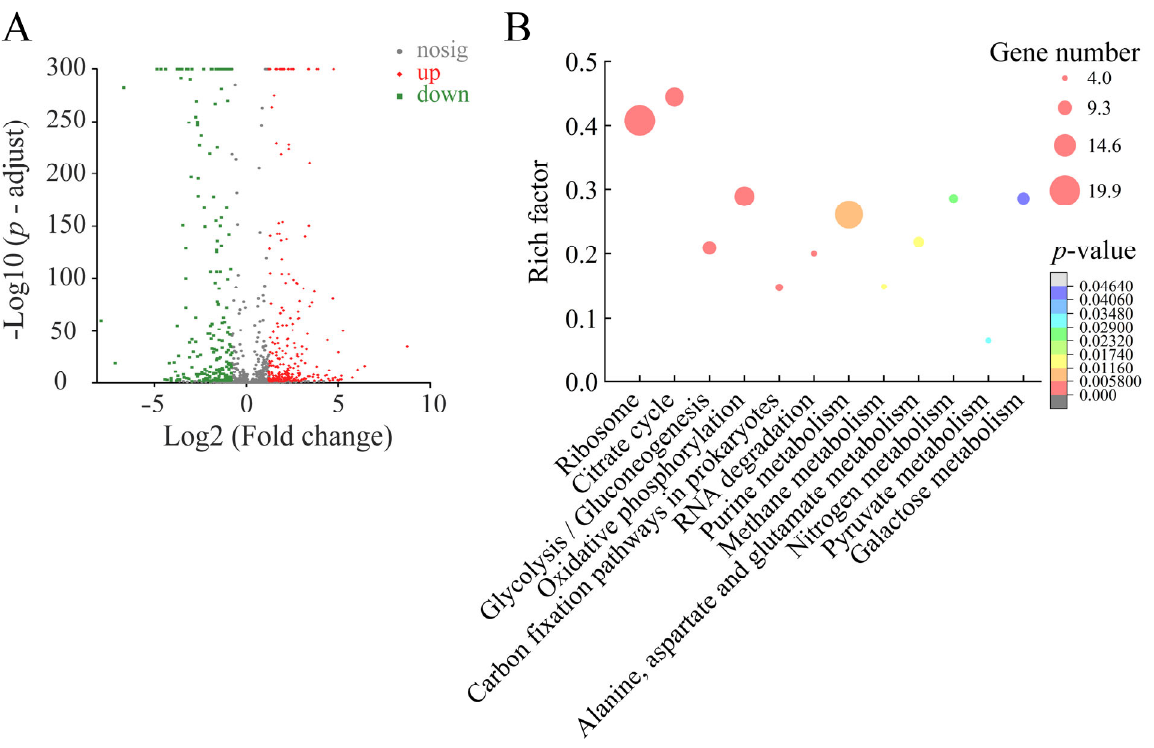
Figure 6. The 12 significantly altered metabolic pathways in S. enterica subsp. enterica ( ex Kauffmann and Edwards) Le Minor and Popoff serovar Vellore ATCC15611 mediated by Fragment 1 from C. communis Linn. ( A , B ) Volcano plot of differential gene expression and significantly changed metabolic pathways in S. enterica subsp. enterica ( ex Kauffmann and Edwards) Le Minor and Popoff serovar Vellore ATCC15611,